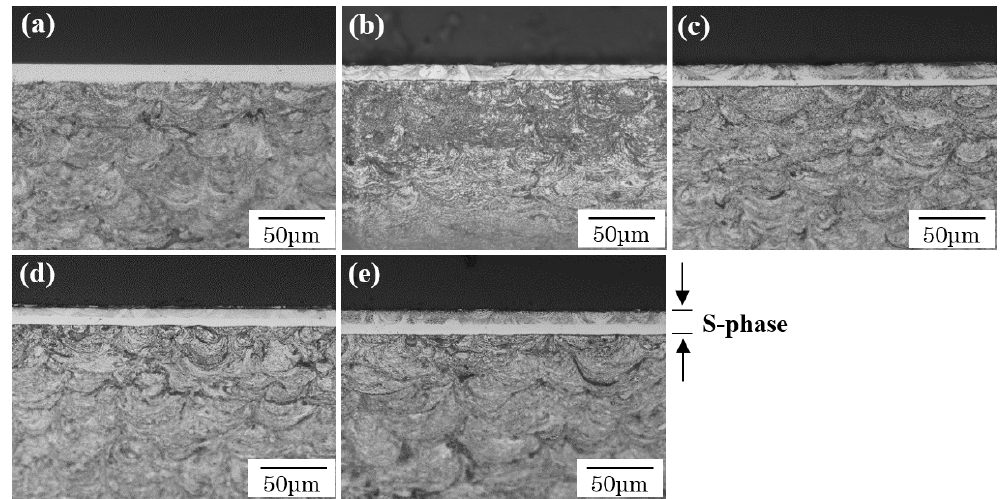
Figure 5. Cross-sectional micrographs of the S-phase layers on cold-sprayed AISI 316L coatings obtained at 450 °C by ( a ) carburizing for 4 h, ( b ) nitriding for 4 h, ( c ) C0.5 h → N3.5 h, ( d ) C2 h → N2 h, and ( e ) (C+N)4 h.